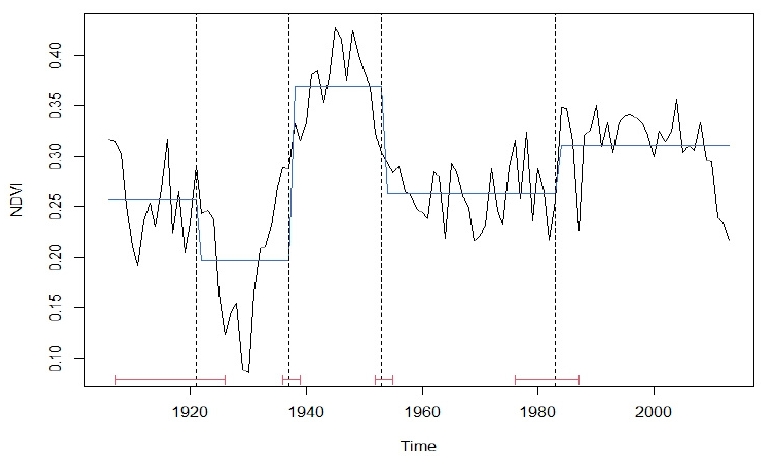
Figure 3. Observed NDVI trends with regime shift dates. The vertical dashed lines indicate the breakpoints, the blue line indicates the fitted NDVI trends, and the bottom red line indicates